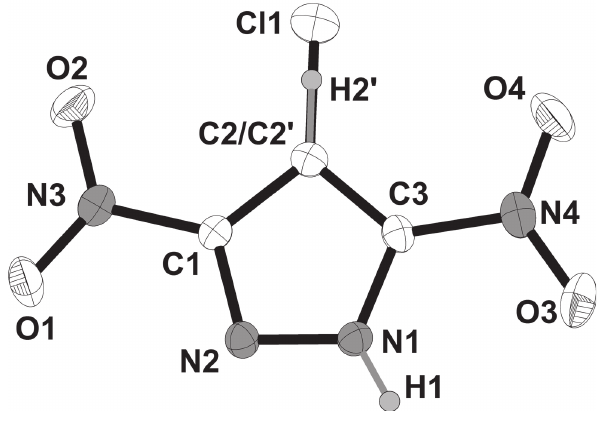
Table 2: Fractional atomic coordinates and isotropic or equivalent isotropic displacement parameters (Å 2